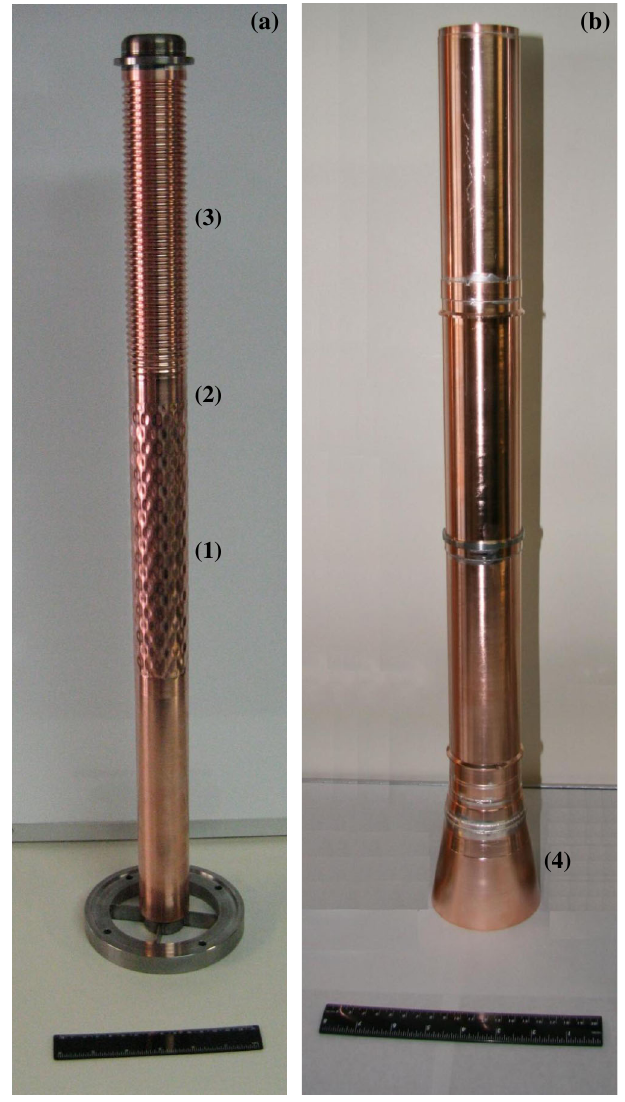
FIG. 9. The results of (a) 3D simulations and (b) “ cold ” tests of the reflection coefficient of a 2D Bragg structure in the frequency band 29 – 32